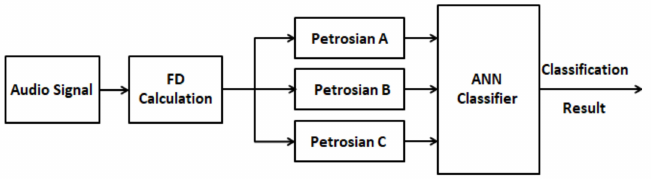
Figure 13. Schematic of the wavelet-based method for fault detection and isolation.